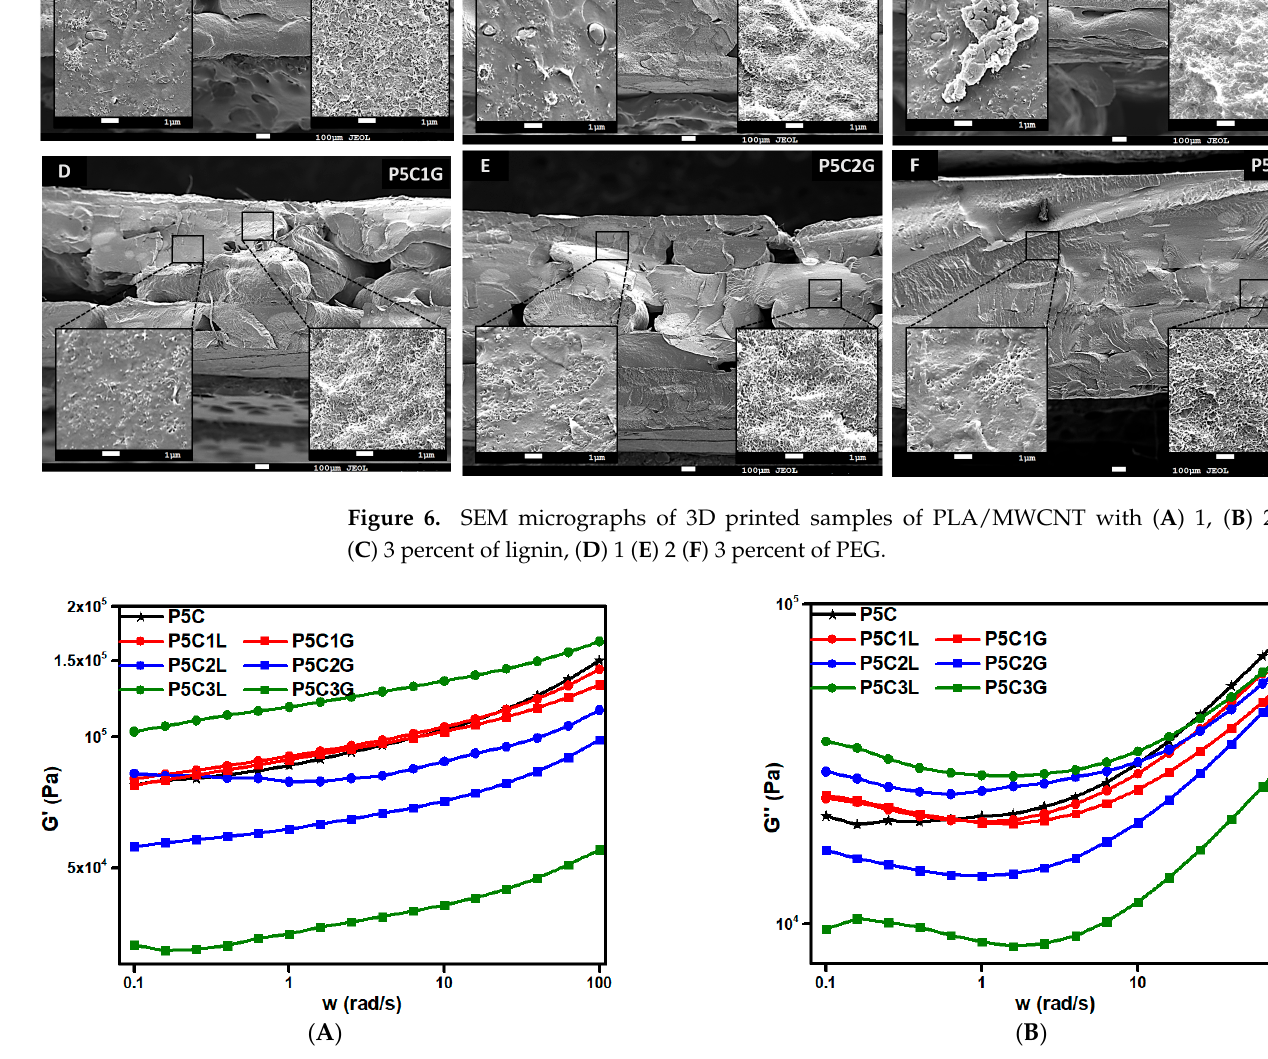
Figure 7. Storage modulus (G ′ ) dependence with ( A ) lignin and ( B ) PEG addition and loss modulus dependence with ( A ) lignin and ( B ) PEG addition.